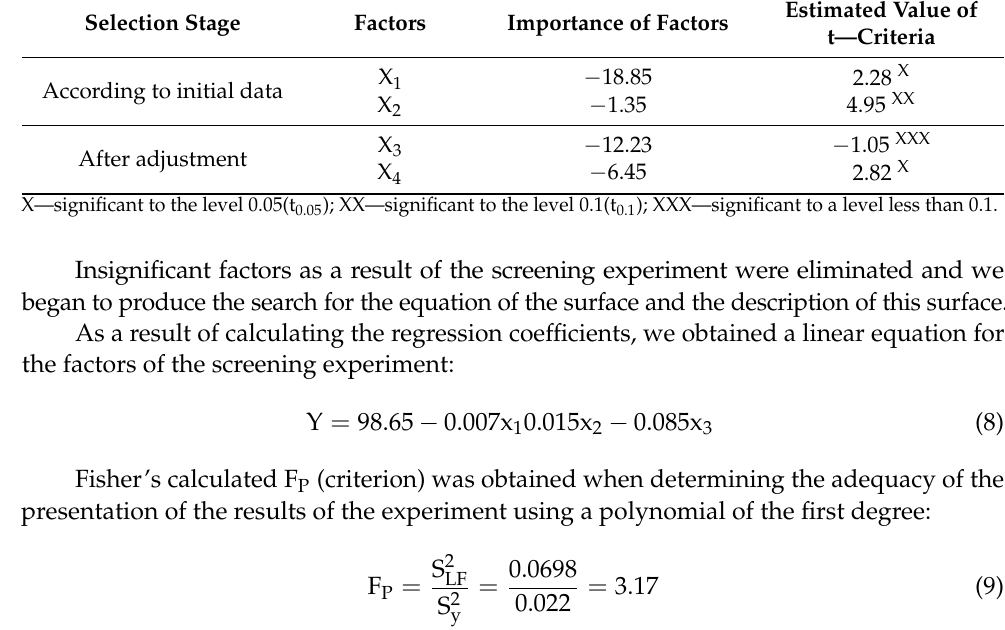
Table 6. The results of the quantitative assessment of the identified factors. Selection